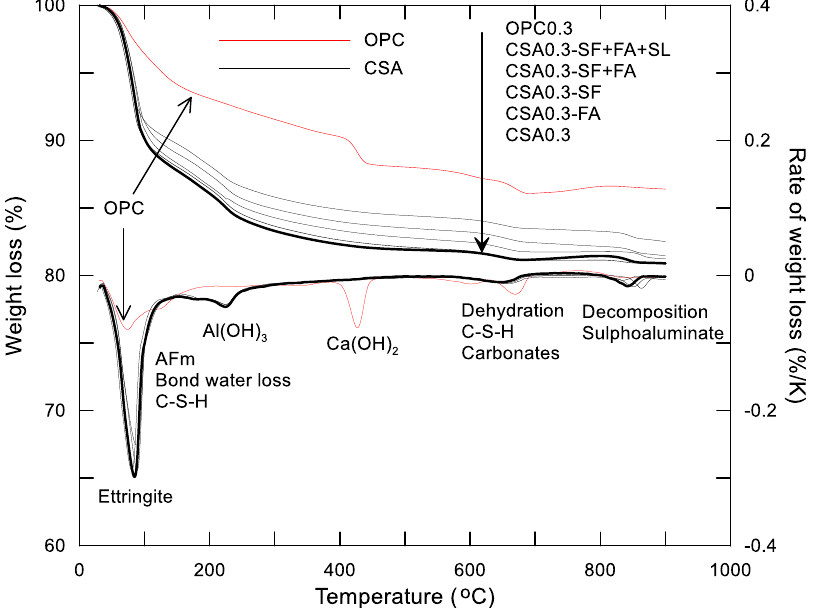
Figure 5. Thermal decomposition analysis (TG-DTG) results of ordinary Portland cement (OPC) and CSA pastes at 3 days.